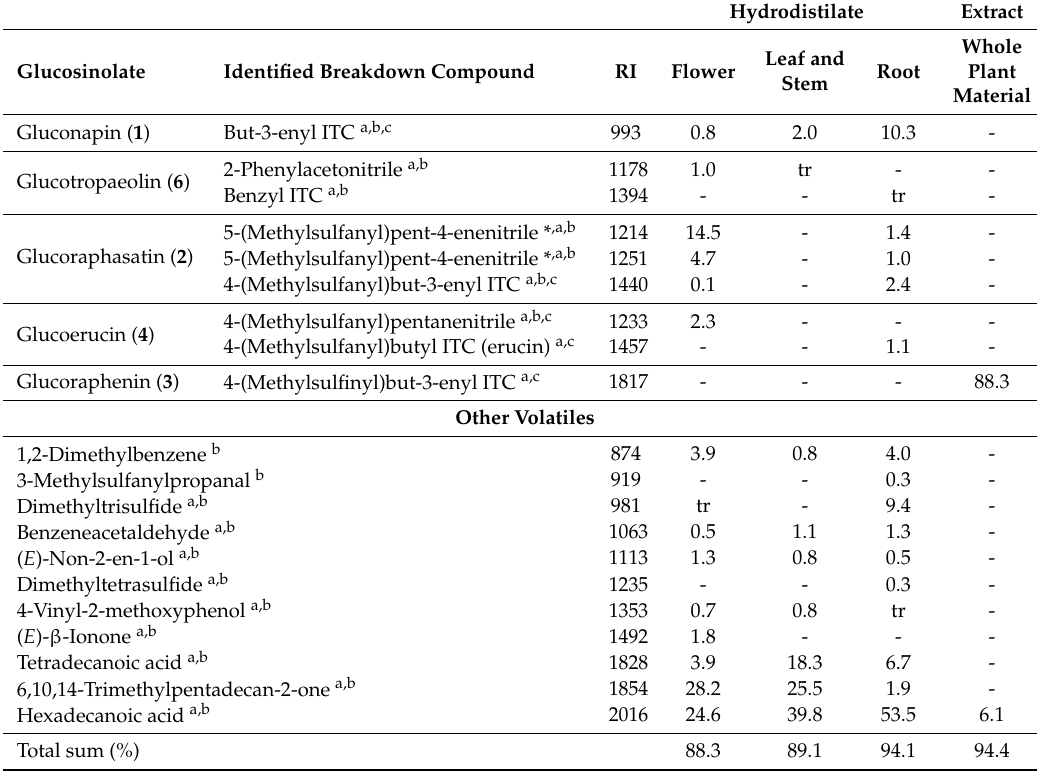
Table 2. Glucosinolates, their breakdown products, and other volatiles identified in different parts of B. erucago by